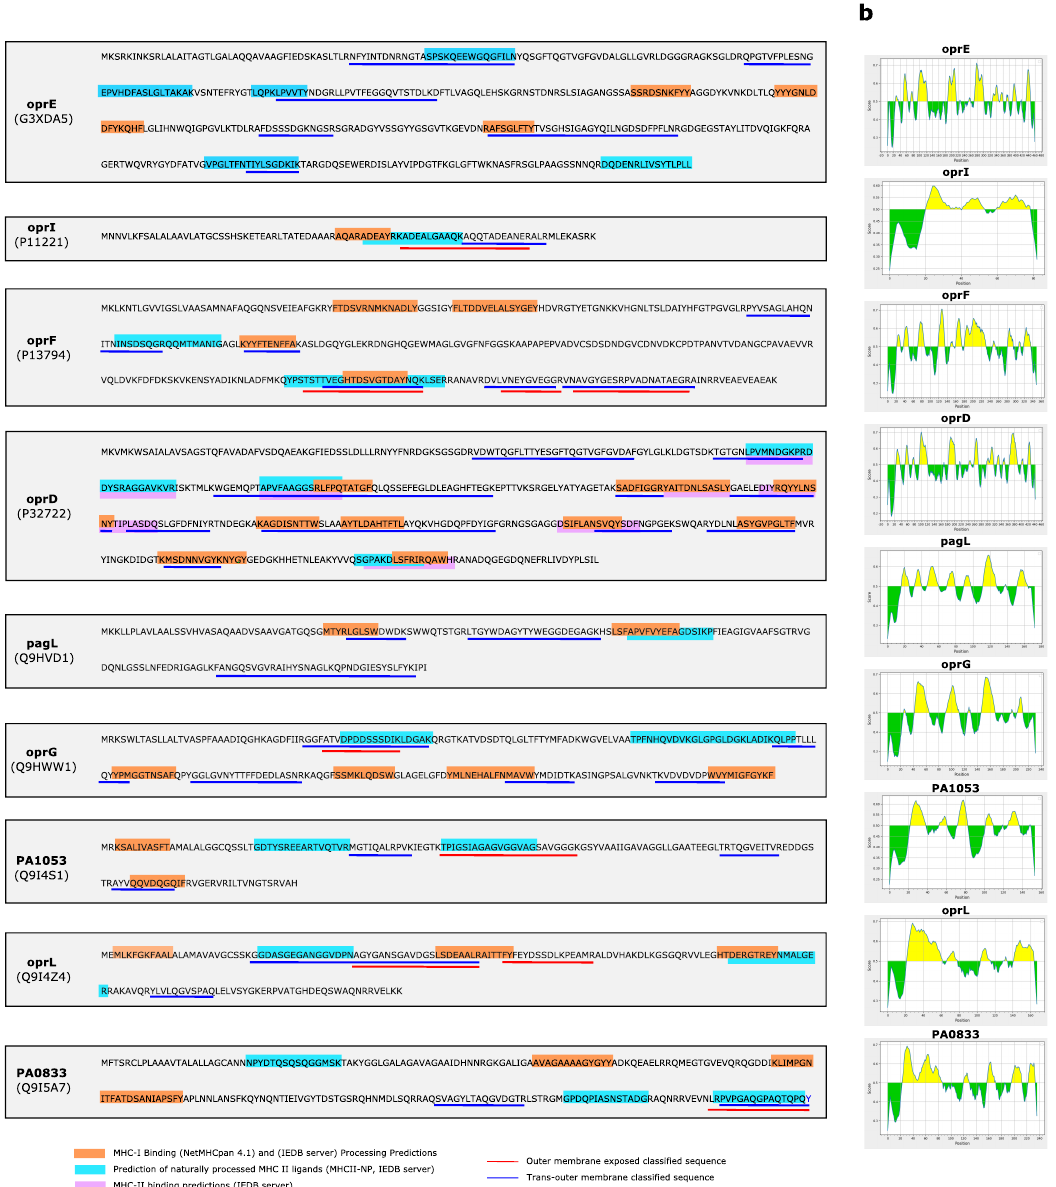
Figure 6. ( a ) Experimentally identified peptides, classified in EXP-OM or T-OM (red and blue lines, respectively), of oOM annotated proteins selected by a Vaxygen score > 0.8. Epitopes putatively bound and processed by T cell MHC Class I and Class II are shown; in orange are highlighted epitopes putatively bound and processed by MHC Class I, while in violet and blue those putatively bound and processed by MHC Class II, respectively. ( b ) Prediction of epitopes, in yellow, putatively bound and processed by B